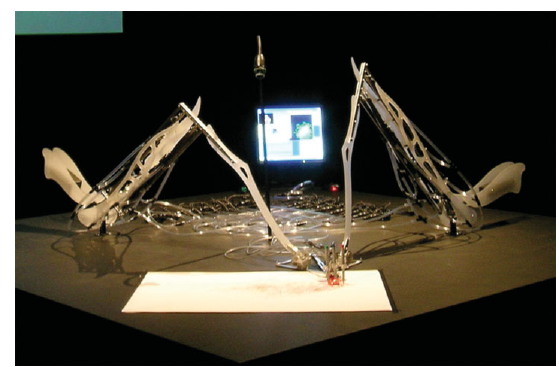
Figure 1. MEART’s body . Two arms cooperated to grip a set of colored pens andmovethemacrossasheetofpaper,accordingtoneuralactivityinaculture dish that was up to 12000 miles away. A CCD camera aimed at the drawing provided sensory feedback to the neuronal network.